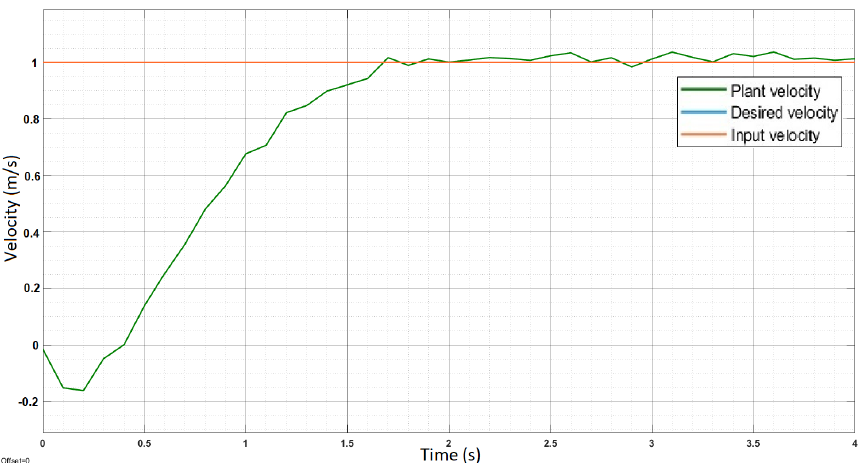
Figure 15. Step response of system with a weight of 80